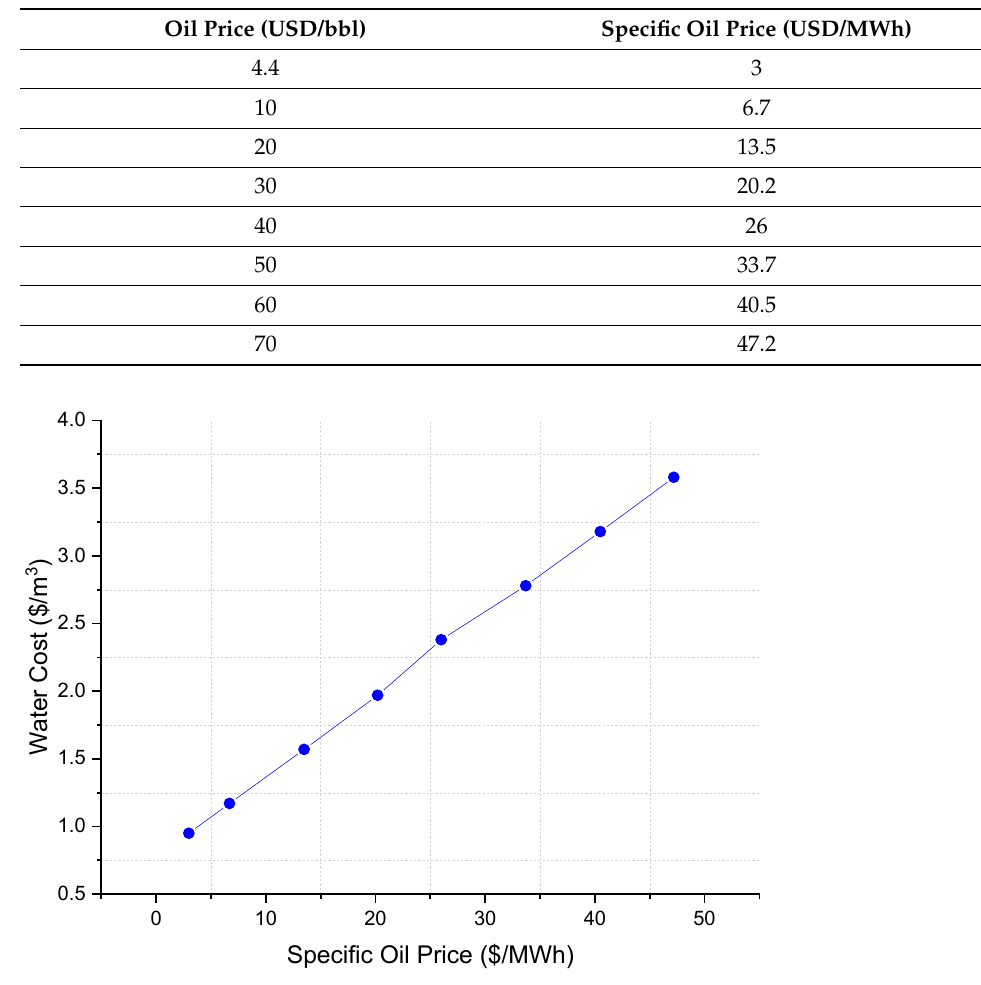
Table 10. Specific oil prices (USD/MWh) for selected oil prices (USD/bbl).